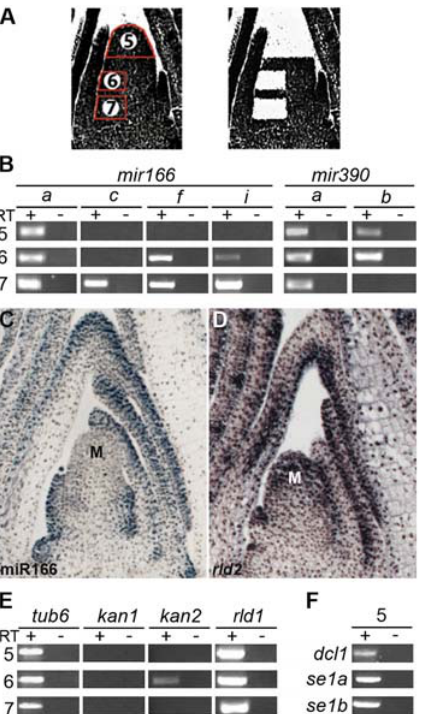
Figure 2. Accumulation of miR166 and miR390 within the SAM is regulated at the level of biogenesis and/or stability. (A) Laser- microdissection of domains within the SAM: 5) the stem cell containing SAM tip; 6) the incipient primordium; 7) the region below the incipient leaf. (B) Expression analysis of mir166 family members by RT-PCR shows that only mir166a , - c , - f and – i precursor transcripts accumulate in or below the incipient leaf and likely contribute to the establishment of organ polarity. In addition, mir166a transcripts are expressed in the SAM tip. Whereas both mir390 precursors are expressed in the tip of the SAM and in the incipient leaf, only mir390a accumulates in the region below the incipient leaf. (C) In situ hybridization of a longitudinal section through a wild-type apex with a miR166 complementary LNA probe shows miR166 accumulates below the incipient leaf and on the abaxial side of the incipient and developing leaf primordia. Note the lack of detectable signal in the tip of the SAM (marked ‘‘M’’). (D) Longitudinal section through a wild-type apex shows rld2 expression in the tip of the SAM, vasculature, and the adaxial side of leaf primordia. (E) Expression of tub6 , kan1 , kan2 , and rld1 in the captured SAM regions is as previously reported [7,23], illustrating the accuracy of laser-microdis- section. (F) RT-PCR analysis for the core miRNA processing genes dcl1 , se1a and se1b in the SAM tip.